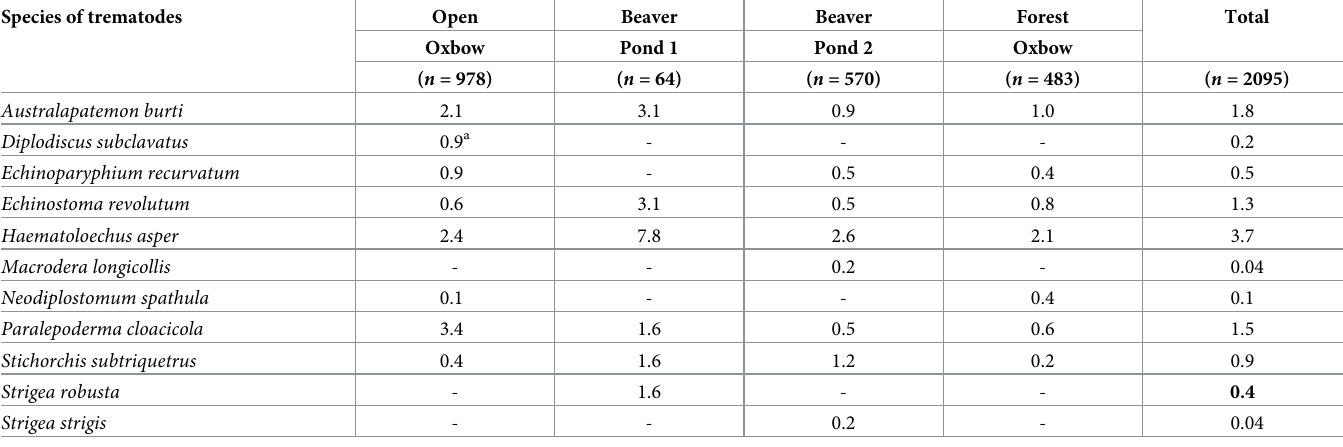
Table 4. Occurrence of trematode species in Planorbis planorbis ( n = 2095). Species of